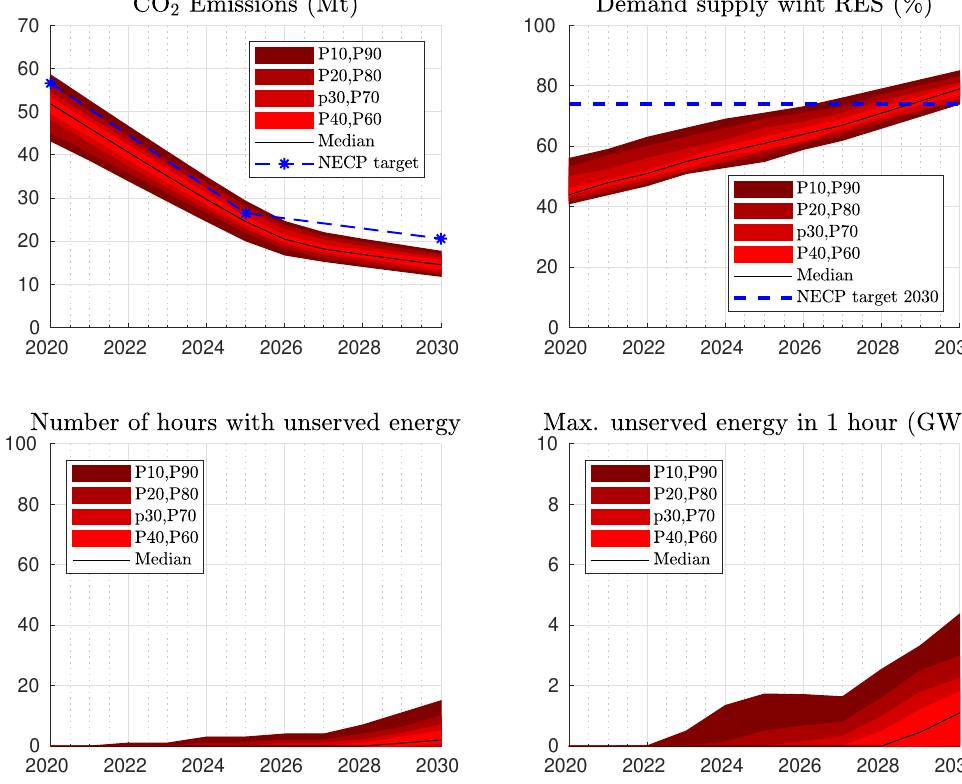
Figure 9. Performance indicators for transition path NECP